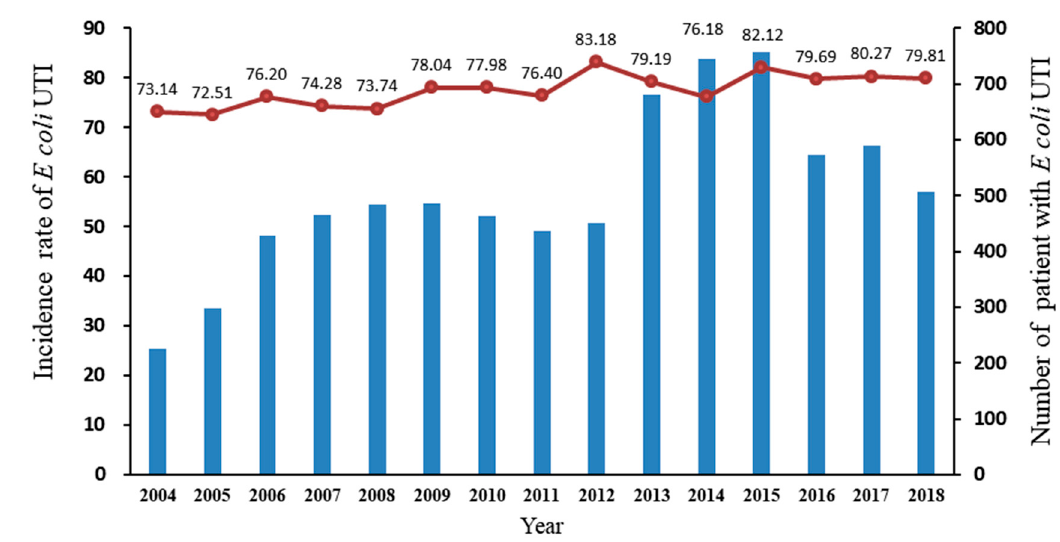
Figure 2. Incidence rate of community-associated E. coli (single isolate) UTI among children aged < 18 years, 2004–2018 (IRR1.01, 95%CI (0.99–1.02), p = 0.2870). The red line indicates annual incidence rate of E. coli UTI, and the blue bars indicate the number of patients with E. coli UTI. The incidence rate ratio (IRR) was derived from a Poisson regression model based on the observed rate in each calendar year. The denominator was all patients with > 10 5 CFU / mL any bacteria isolated UTI in each calendar year.